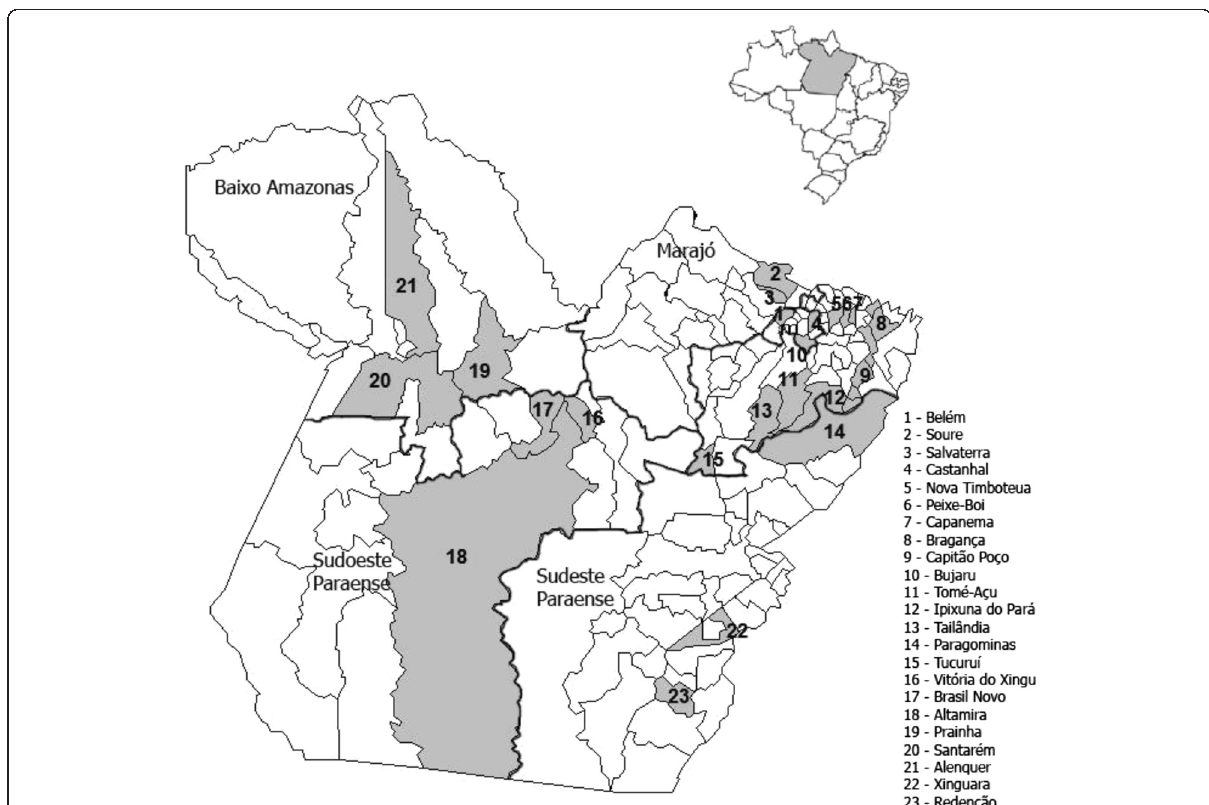
Figure 1 Map of the State of Pará depicting the mesoregions (thick line) and municipalities (solid gray area) where serum from horses were